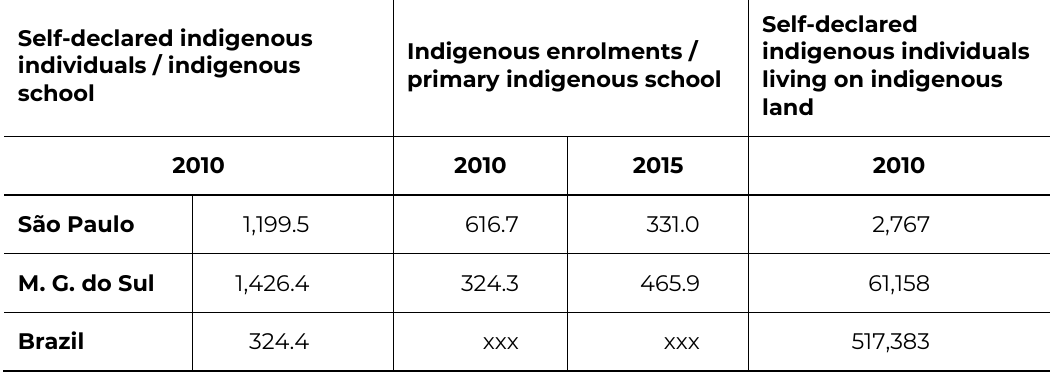
Table 4 consolidates some key data on the number of people who claim their indigenous heritage and live on indigenous land, together with the ratio of enrolment of indigenous pupils per indigenous school and the ratio of self-declared indigenous people per school available in the area where they live.